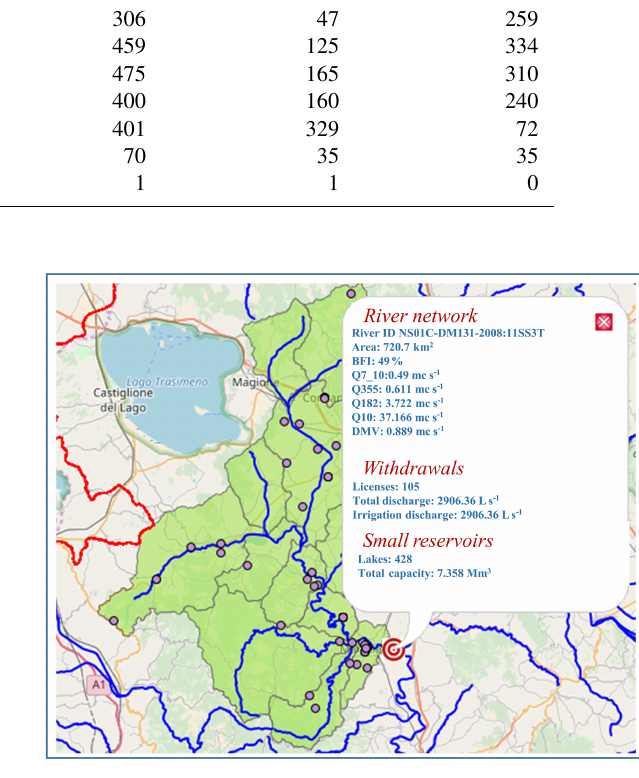
Figure 2. WebGIS spatial query example: withdrawals from rivers and wells and small-reservoir availability. ©Google (Base) Map source: Dati